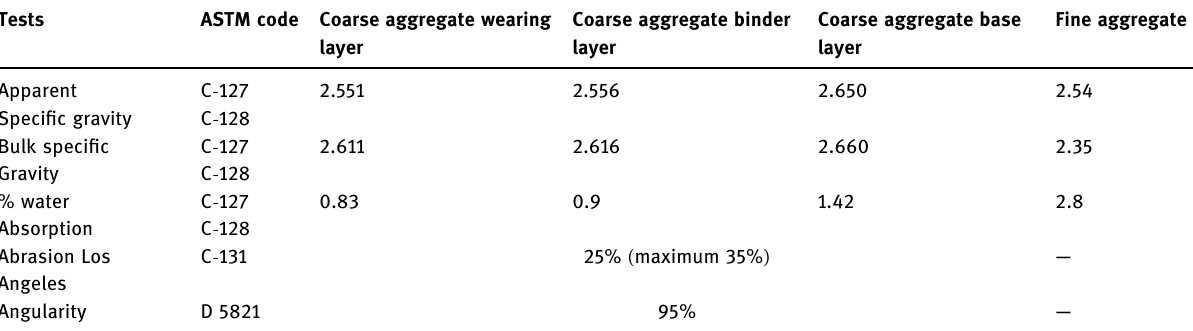
Table 2: Aggregate ’ s physical properties